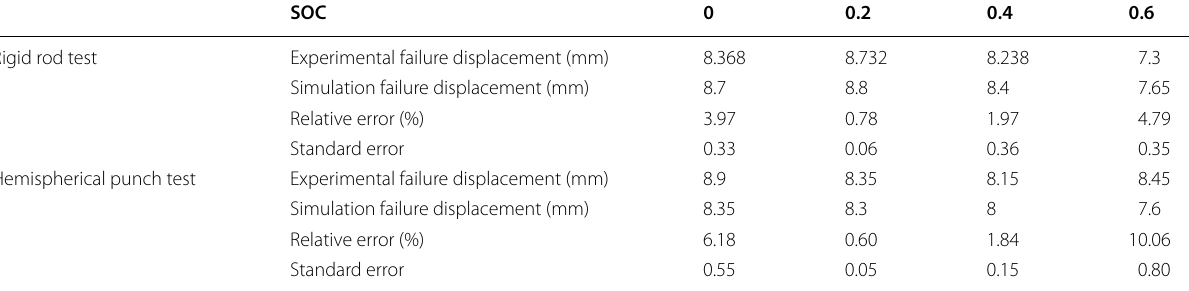
Table 8 Failure displacement by experiment and simulation and corresponding relative error SOC Rigid rod